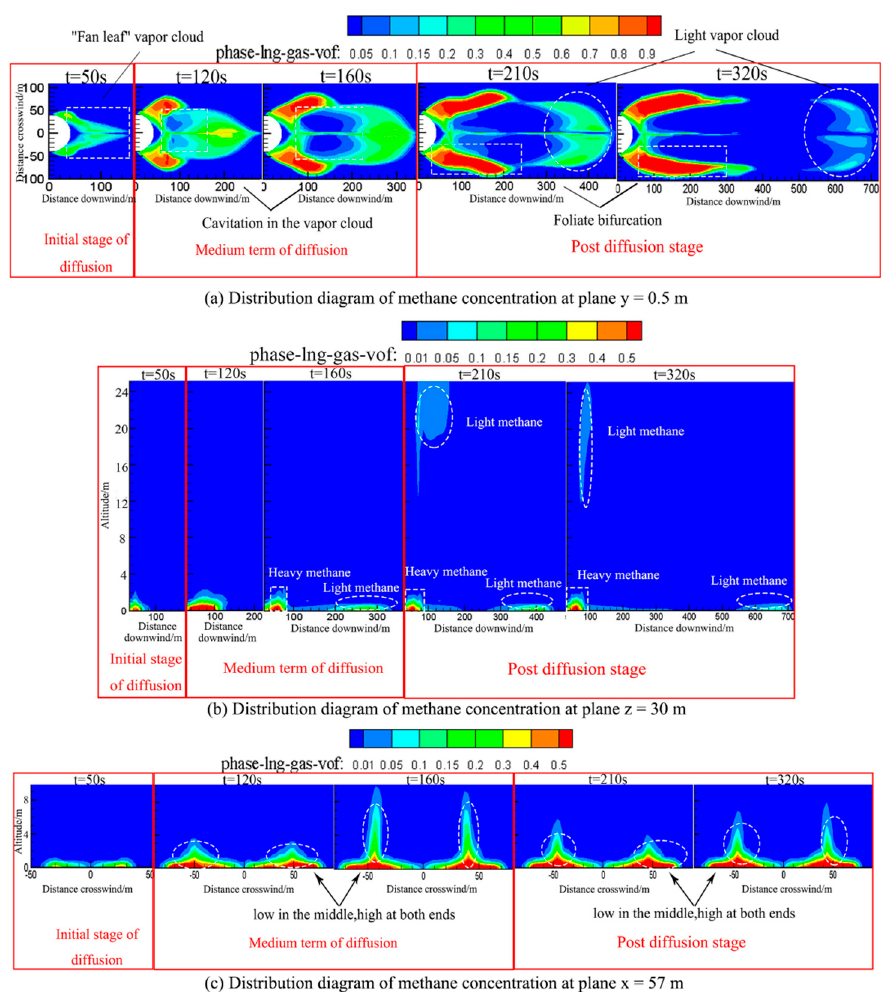
Figure 9. Distribution of methane concentration in different planes. ( a ): Distribution diagram of methane concentration at plane y = 0.5 m; ( b ): Distribution diagram of methane concentration at plane z = 30 m; ( c ): Distribution diagram of methane concentration at plane x = 57 m